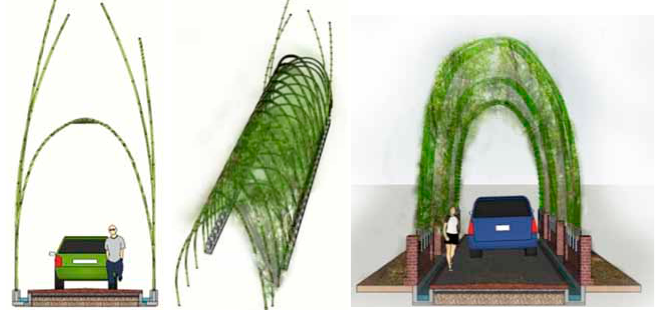
fig. 10. Designed object placed for alleyways (created by the author) fig. 11. rendered image of suggested design for alleyways (created by the author)